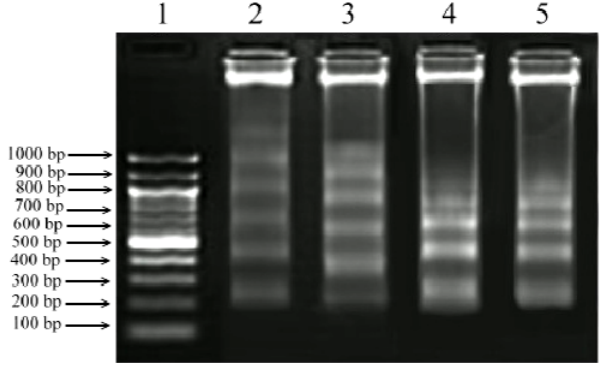
Figure 6. DNA fragmentation induced by isolated PEs and PMA in MCF-7 and HeLa cancer cell lines at IC concentration. The extracted DNA was run on 2% agarose gel and 50 the image was documented using Bio-Rad Gel documentation system. Lane 1: 1 kb DNA ladder;